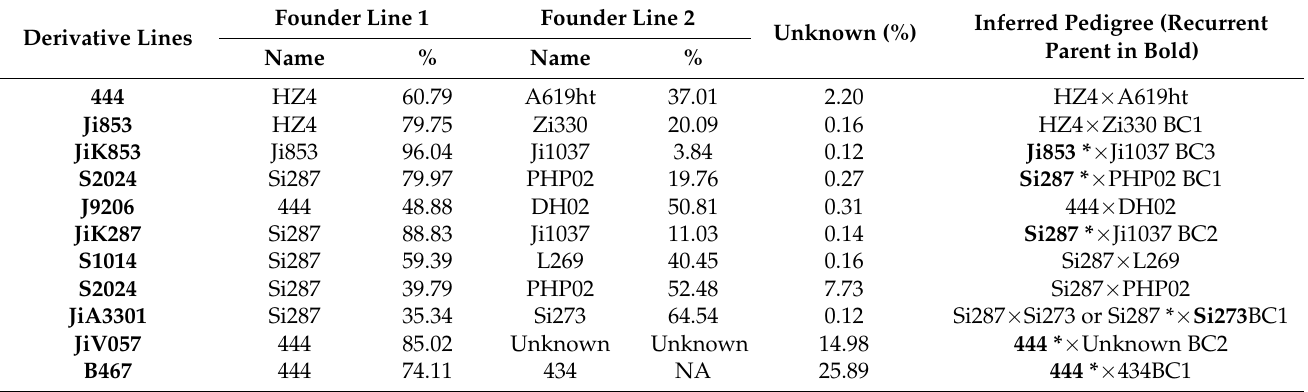
Table 3. The inferred genome composition of derivative line based on genome-wide SNP data and comparison between their bi-parental founders from the empirical